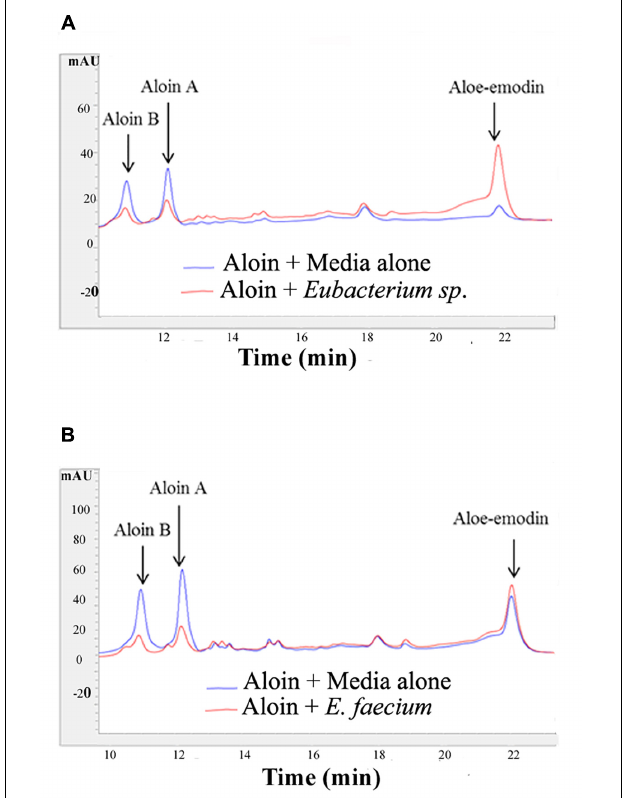
FIGURE 2 | Aloin metabolism by intestinal bacteria Eubacterium sp. and E. faecium after incubation. (A) Top panel shows aloin metabolism by Eubacterium sp. under anaerobic conditions. (B) The bottom panel shows aloin metabolism by E. faecium under anaerobic conditions. The arrow shows the peak area and retention times of aloin isoforms and aloe-emodin.